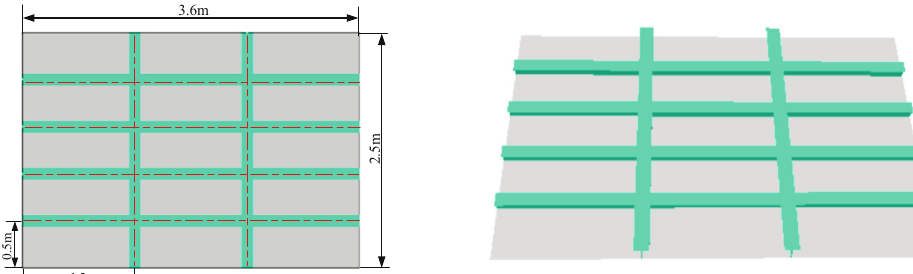
Figure 10: Grillage geometry